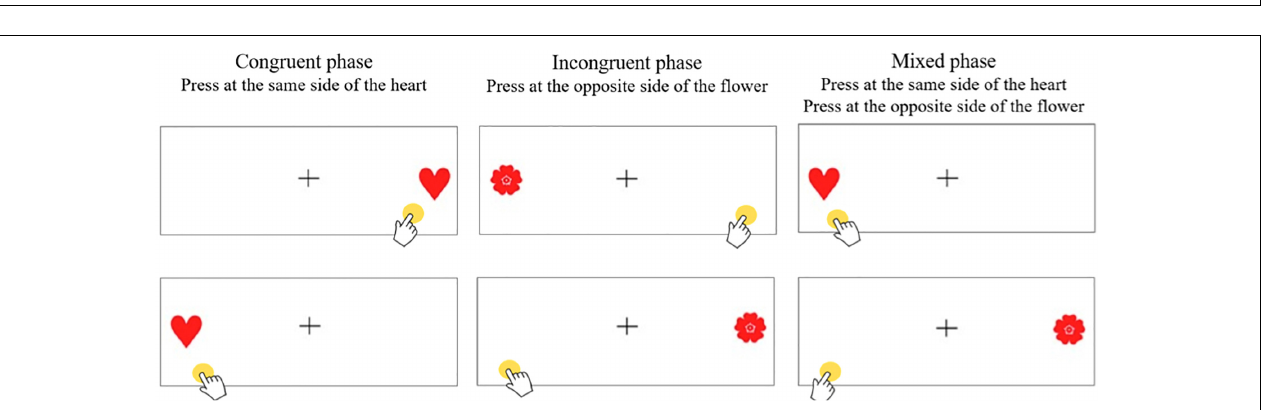
FIGURE 1 | Distribution of time during the research process.